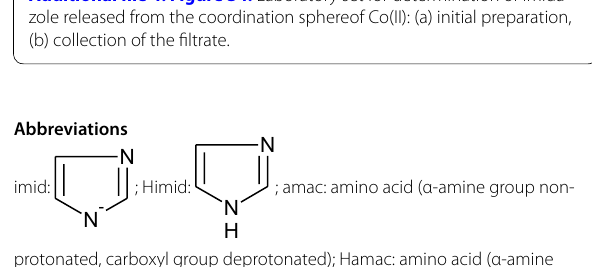
Additional file 1: Figure S1. Determination of stoichiometry of the O 2 uptake by the molar ratio method in the Co(II) – amac – Himid – O 2 sys- tems. L-α-amino acid (amac) (a) alanine, (b) asparagine, (c) histidine. C L = – total concentration of amac, C Co – total concentration of Co(II). Mmole O 2 – number of mmol of dioxygen taken up. All the samples contained 0.3 mmol of Co(imid) 2 in 30 mL of solution. Additional file 2: Figure S2. Titration curve of the water-acetone filtrate obtained when the dioxygen adduct formed in aqueous solution pre- cipitated in acetone. Co(II) : amac : Himid at a molar ratio of 0.3 : 0.9 : 0.3 (mmol); L-α-amino acid (amac) (a) alanine, (b) asparagine, (c) histidine. = Additional file 3: Figure S3. Laboratory set for pehametric – volumetric measurements. Additional file 4: Figure S4. Laboratory set for determination of imida- zole released from the coordination sphereof Co(II): (a) initial preparation, (b) collection of the